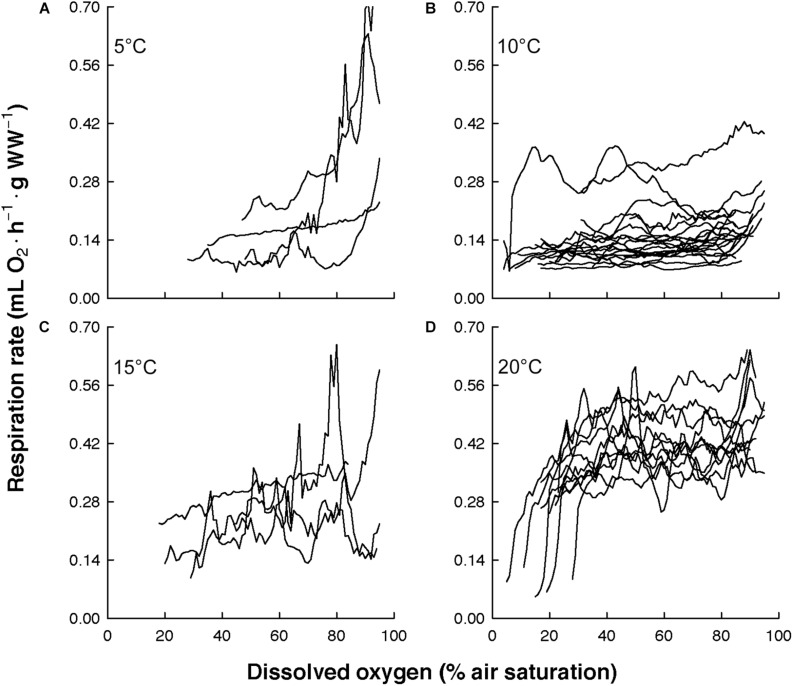
Respiration rates of Euphausia hanseni over decreasing dissolved oxygen concentration at four temperatures. (A) at 5°C (n = 4), (B) at 10°C (n = 22), (C) at 15°C (n = 4), and (D) at 20°C (n = 11).